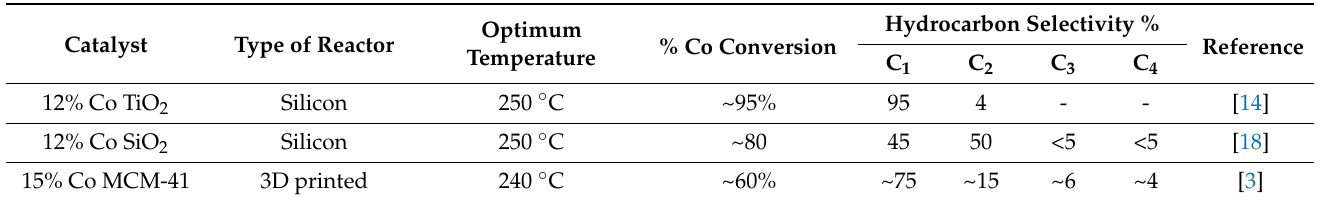
Table 1. Performance of cobalt-based catalysts in previous studies on atmospheric FT synthesis in microchannel